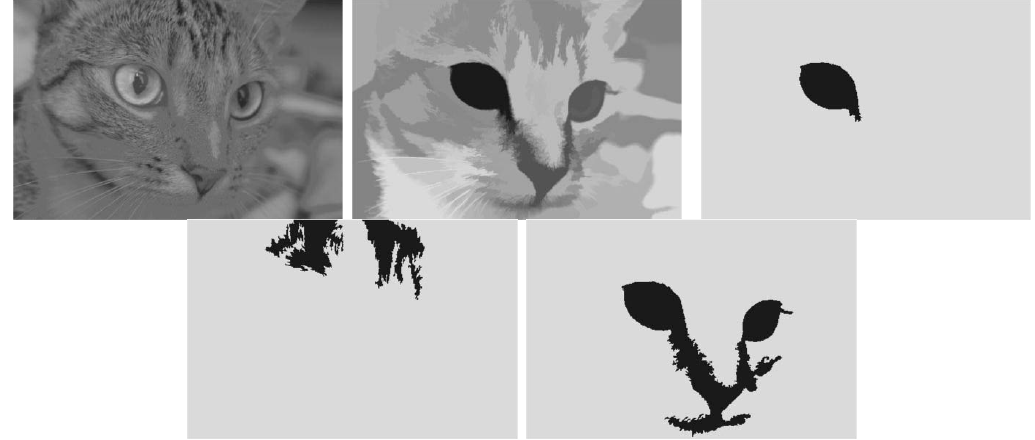
Fig. 6. Cat image at scales 1 to 4030, 4031 to 58571, 4234 to 4235, 4325 to 4335, and 14565 to 14575